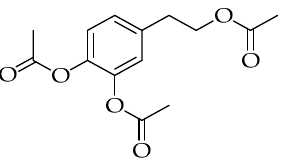
Figure 3. Chemical structure of HTyr triacetate (peracetyted HTyr, Per-HTyr) [72].